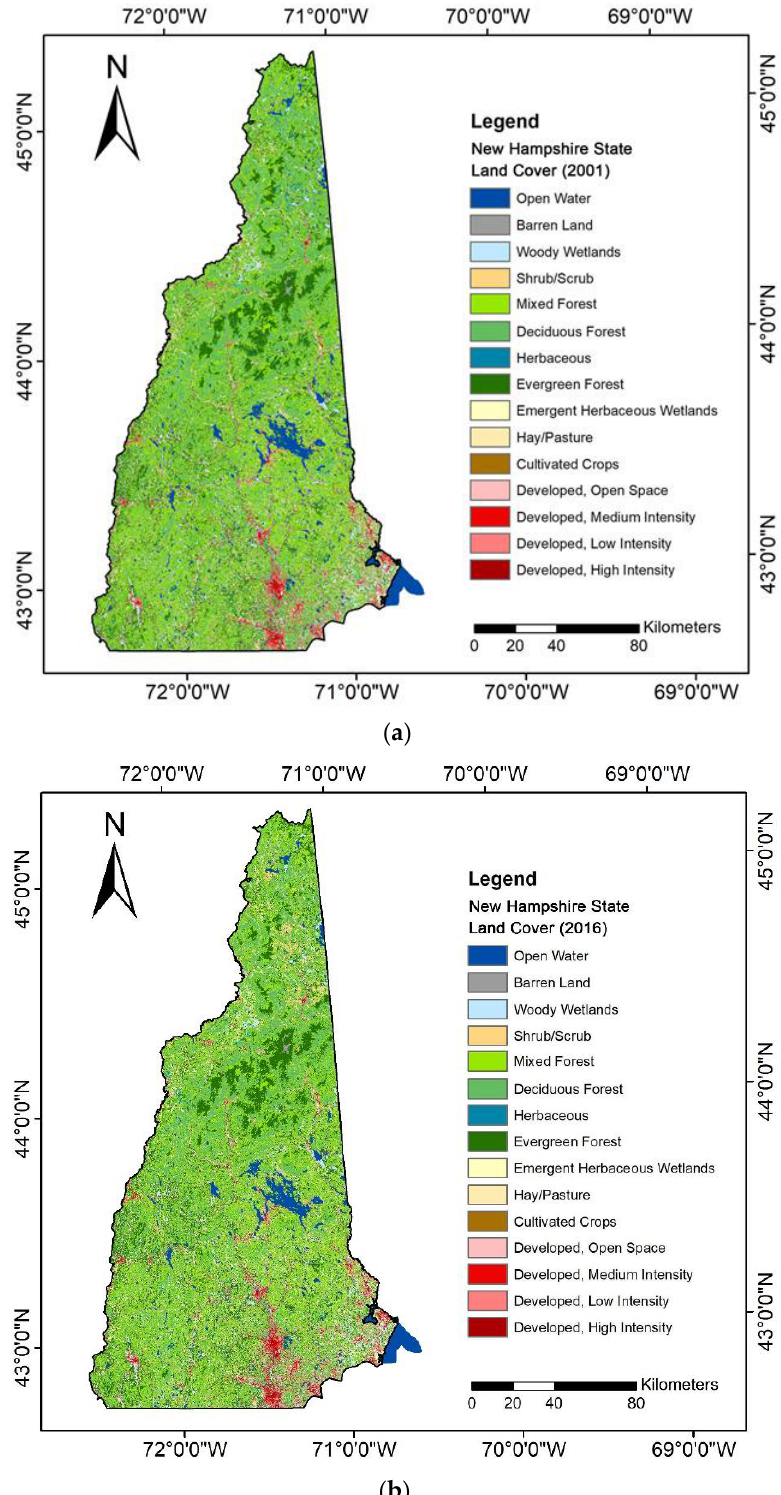
Figure 3. Land cover maps of New Hampshire (U.S.A.): ( a ) 2001, ( b ) 2016 (Latitude: 42° 42′ N to 45 ◦